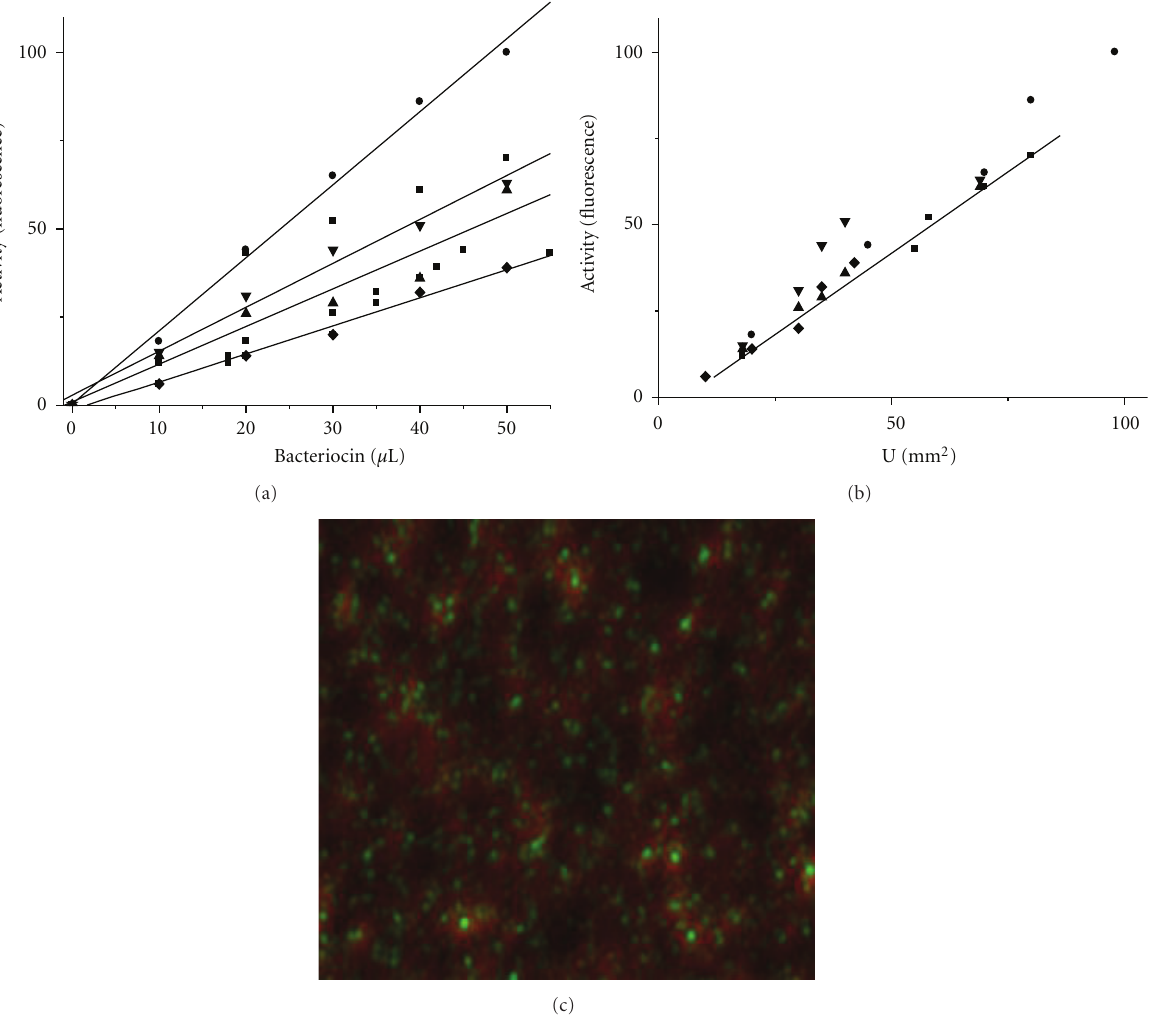
Figure 1: (a) Fluorescence emitted by berberine sulfate upon influx into Salmonella sp. treated with di ff erent concentrations of bacteriocins produced by B. thuringiensis . (b) Correlation ( r = 0.94) between the bacteriocin activity in mm 2 of inhibition area and fluorescence. Morricin 269 ( (cid:2) ); Kurstacin 287 ( • ); Kenyacin 404 ( (cid:3) ); Entomocin 420 ( (cid:4) ); Tolworthcin 524 ( (cid:5) ). (c) Fluorescence emitted by berberine sulfate inside Salmonella sp. after the e ff ect on cytoplasmic membrane induced by bacteriocin Kurstacin 287. Table 1: Correlation coe ffi cient between the fluorogenic method and well di ff usion assay. Correlation Strain Morricin 269 Kurstacin 287 Kenyacin 404 Entomocin 420 Tolworthcin